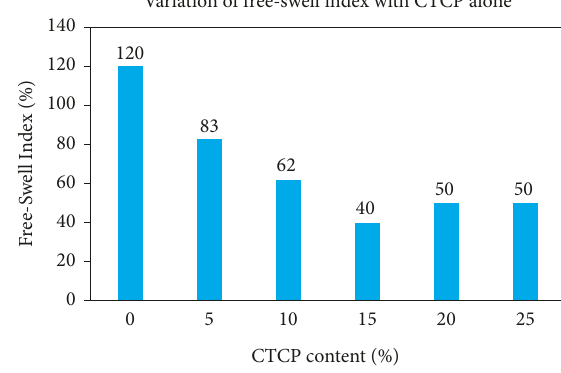
Figure 8: Effect of CTCP on the free-swell index.